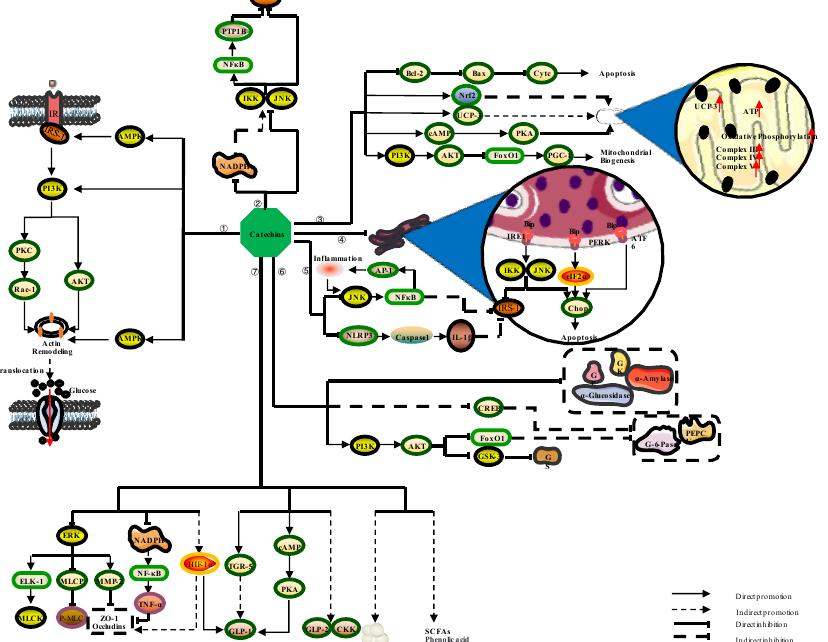
Figure 4. The pathway by which catechins regulate diabetes: (1) Catechins activate APMK and PI3K, and enhance insulin sensitivity, ultimately promoting uptake of glucose by the cells. (2) Catechins attenuate the inhibitory effect of NF κ B on IRS-1 by suppressing the activity of NADPH, redox- sensitive signaling molecules IKK, JKN. (3) Catechins promote glucose-stimulated insulin secretion by increasing mitochondrial oxidative phosphorylation and ATP production, while increasing mito- chondrial biogenesis and reducing mitochondria-associated enzyme-induced apoptosis of β -cells. (4) Catechins reduce ER stress by alleviating UPR, which leads to IRS-1-related decreased insulin sensitivity and β -cell apoptosis. (5) Catechins alleviate IRS-1-related insulin sensitivity reduction caused by inflammation by inhibiting NLRP3 and JNK. (6) Catechins decrease the source of blood glucose by reducing the activities of related enzymes, such as GK, GP, G-6-Pase, PEPCK, α -amylase, and α -glucosidase, and improve the activity of GS in promoting glycogen synthesis. (7) Catechins regulate diabetes by improving the gut barrier, balancing gut microbes, and promoting the secretion of glucose-related gut hormones.